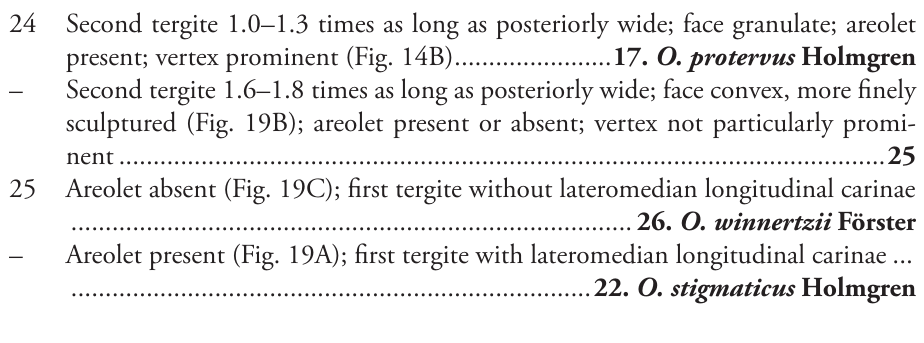
Description. Female. Fore wing length 3.0–3.5 mm. Face at level of antennal sockets 1.4 times as wide as high; face smooth, pol- ished, sparsely and slightly punctate; eyes not setose; dorsal ridge of face in between antennal sockets with a median blunt low prominence; face profile straight except dorsally very slightly impressed; inner eye orbits slightly divergent ventrally; edge of clypeus straight; antennal sockets not on a distinct high shelf; subocular sulcus distinct, sharp, slightly bent towards occiput; maxillary palp reaching fore coxa. In dorsal view, head posteriorly concave, temples short; lateral ocellus separated from eye by its maximum diameter; POL 1.8 times as long as diameter of lateral ocellus; ocellar-ocular grooves present. Minimum distance between antennal sockets about 0.4× diameter of socket; antenna very short, with 19 flagellomeres (n = 15) gradu- ally shortening towards apex of antenna; basal flagellomere 1.5 times as long as wide and about 0.4× of length of scape; scape slightly convex on inner surface, slightly concave on outer